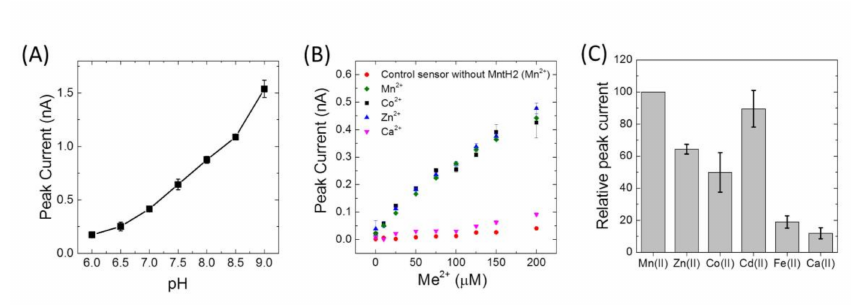
Figure 4. ( A ) Electrophysiology peak currents as a function of pH for MntH2 proteoliposomes (LPR 10:1 ( w / w )) with MntH2 from which the octa-histidine tag was removed. Bu ff er was 5 mM MES / HEPES / CHES, 150 mM KCl, 2 mM MgCl 2 Peak currents are obtained with 100 µ M Mn(II) and corrected for background currents, which were obtained by measuring electrophysiology traces in the presence of 1 µ M valinomycin. ( B ) Peak currents recorded from a single sensor in 10 mM HEPES, pH 8.0, 150 mM KCl, 2 mM MgCl 2 with his-tagged MntH2 proteoliposomes (LPR 10:1 ( w / w )) as a function of the tested divalent metal (Me 2 + ), as indicated. The control experiment was performed on a di ff erent sensor prepared with liposomes without MntH2. ( C ) Relative peak currents obtained with 100 µ M of the indicated metals for four di ff erent sensors in 10 mM HEPES, pH 8.0, 150 mM KCl, 2 mM MgCl 2 with his-tagged MntH2 proteoliposomes (LPR 10:1 ( w / w )). The data between sensors are normalised for the peak current measured with 100 µ M Mn(II). For Fe(II), 1 mM of ascorbic acid was added to prevent oxidation to